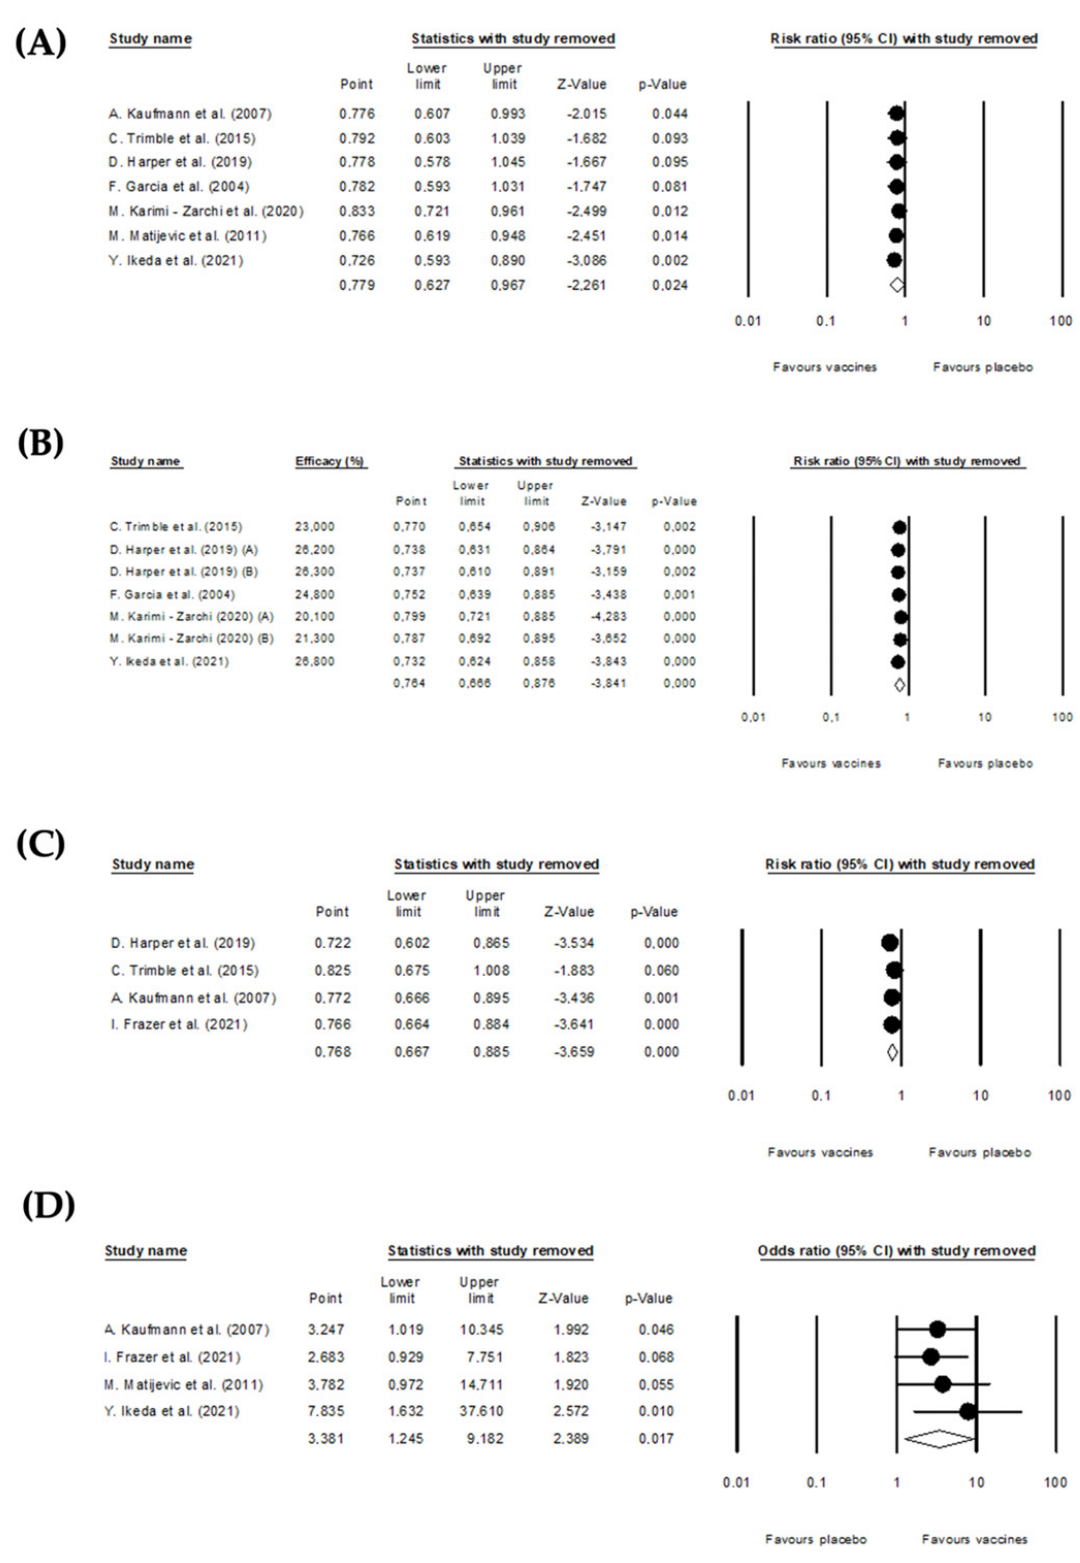
Figure 8. Sensitivity analysis excluding one or more studies from the analysis to see how this affected the results. ( A ) Histopathological regression to CIN ≤ 1 [35–38,41,42], ( B ) efficacy for complete resolution [35–37,39,41], ( C ) DNA clearance [35,37,38], ( D ) HPV-T cell response